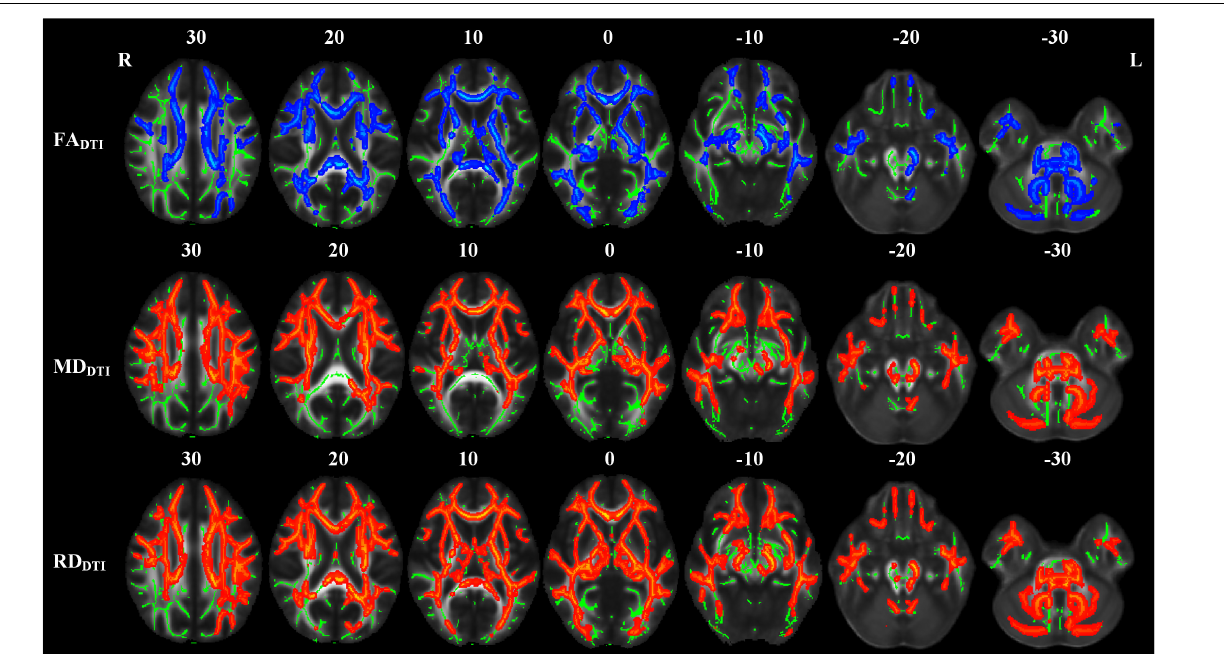
Frontiers in Aging Neuroscience |